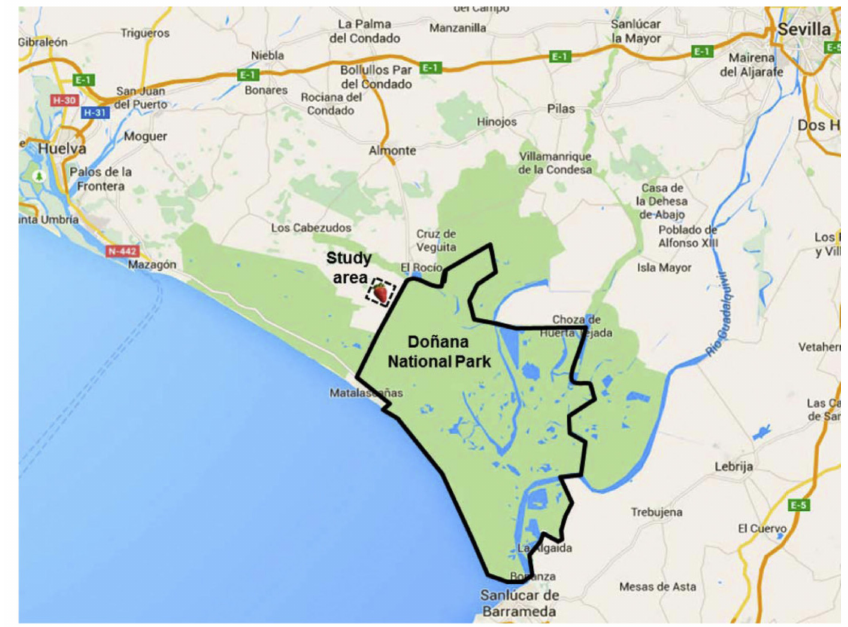
Figure 2. Location of the Doñana National Park and the study area